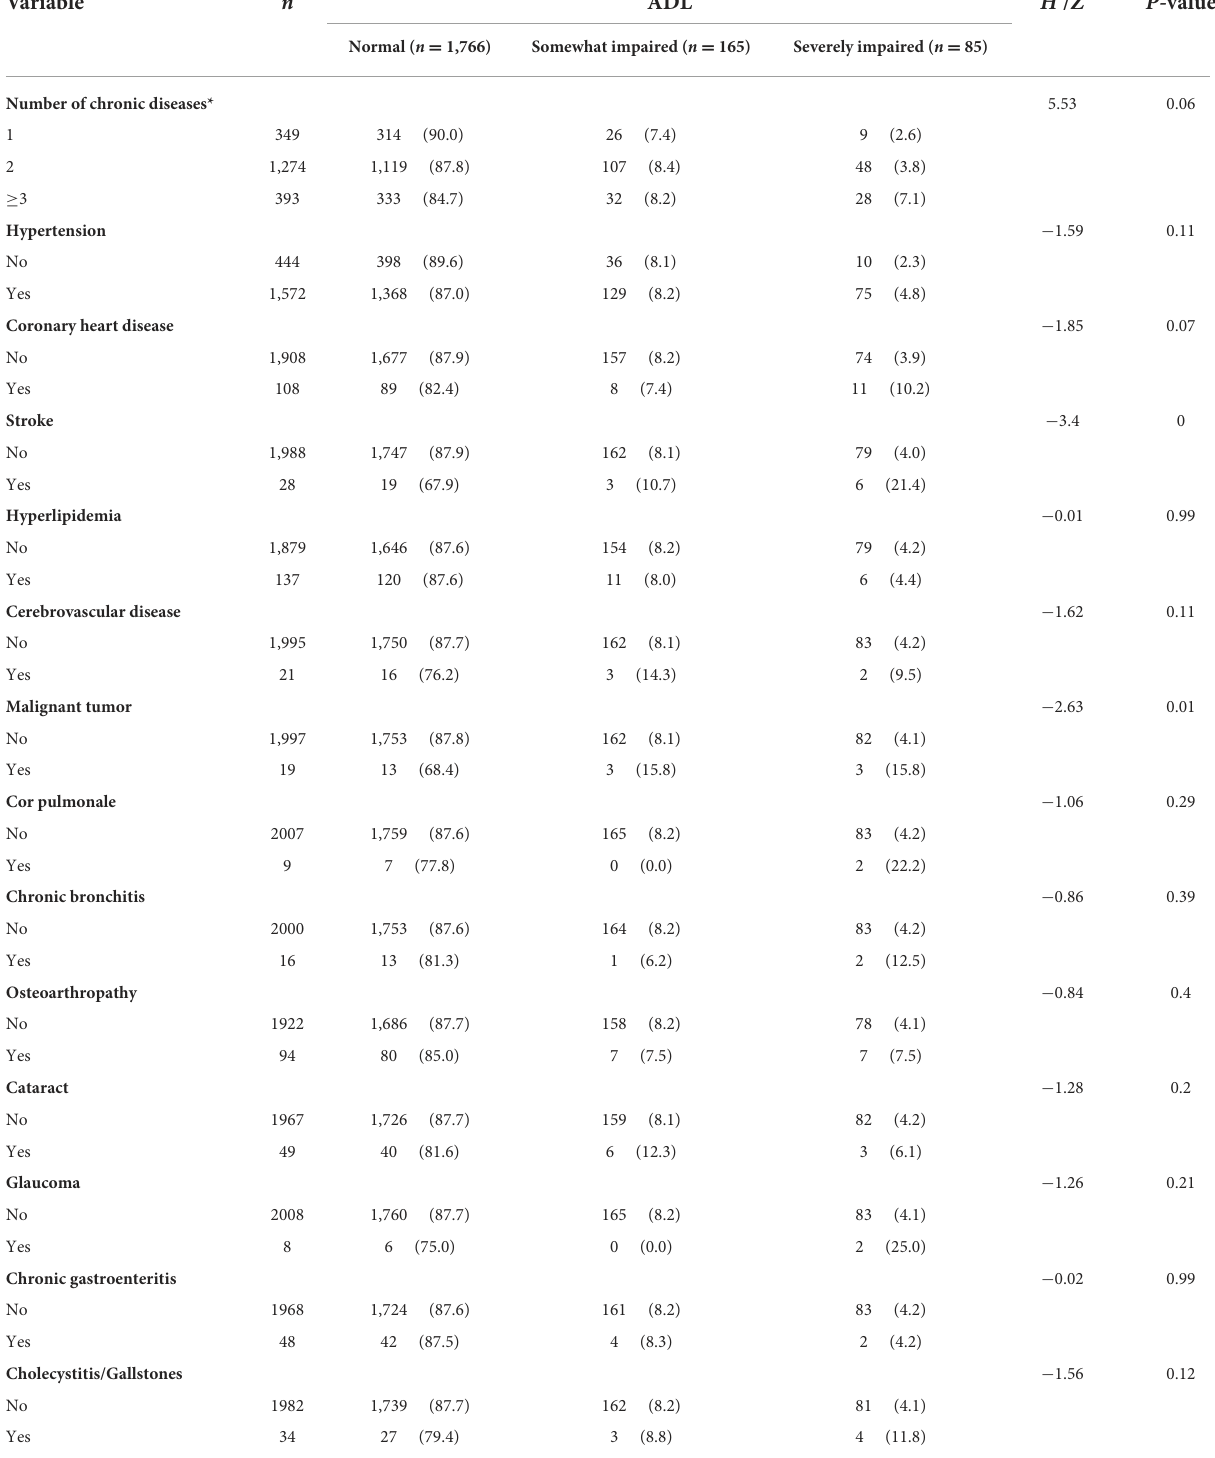
TABLE 5 Comparison of activities of daily living (ADL) functions by different chronic diseases in older people with type 2 diabetes in Fuzhou. Variable n ADL H / Z P -value Normal ( n = 1,766) Somewhat impaired ( n = 165) Severely impaired ( n =